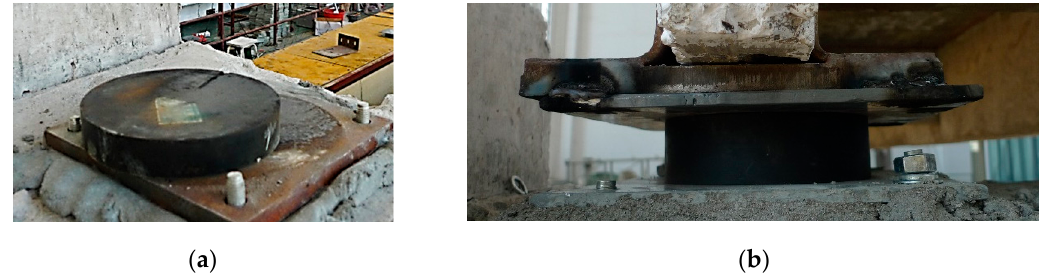
Figure 4. Bearing types: ( a ) laminated rubber bearing ( b ) high damping rubber bearing.